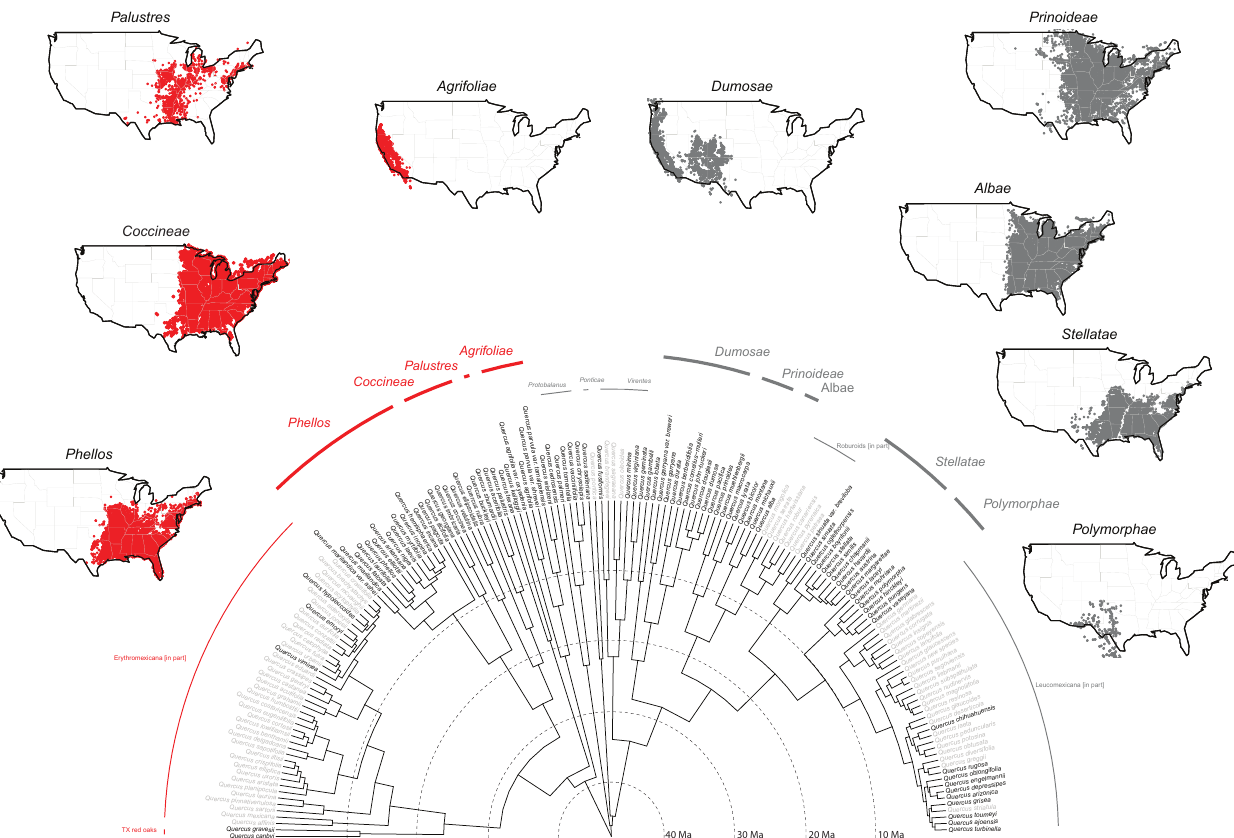
Figure 2. Time tree/chronogram of the five sections of the American oak clade ( Quercus subg. Quercus ) adapted from [19], with distribution maps for the nine subsections recognized within sections Lobatae and Quercus . Shown in boldface are 88 of the 92 taxa that occur within the FNA region. Ma = million years ago. Maps are based on specimen data used in [19], excluding specimen records from cultivation and from outside the range of the species; additionally, populations of Q. havardii from west of eastern Arizona were excluded as their taxonomic status and possible hybrid origin are uncertain [68,69]. Additional specimen data from SEINet were included for the Coccineae in North Carolina, which were undersampled. Code for generating maps and phylogenetic tree is archived in GitHub (https://github.com/andrew-hipp/2021-oak-classification, Release v0.95-1, 2021-06-06) and Zenodo (DOI: